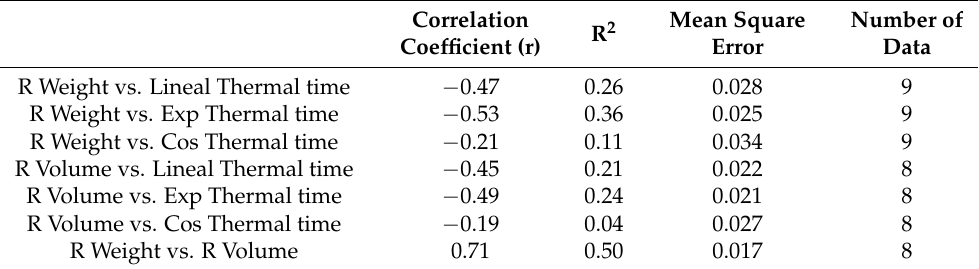
Table 3. Correlation coefficient and number of data in the relationships between relative weight and volume at the end of Period I of endocarp development with thermal time